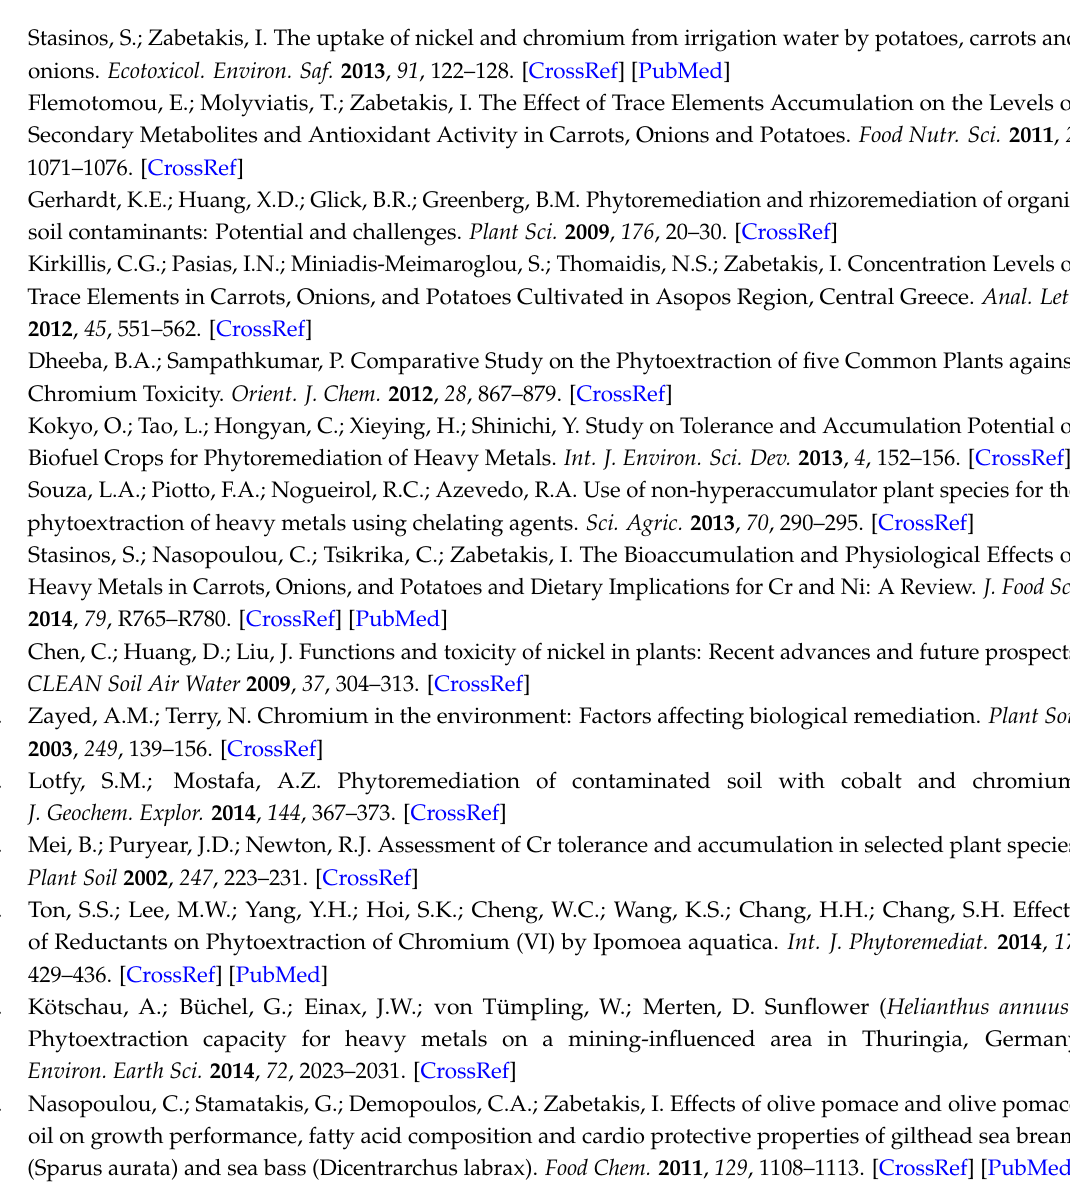
Figure S1: Levels of: (a) chromium and (b) nickel as determined by Atomic Absorption Spectroscopy (AAS) in roots, shoots, leaves, and blossoms in different irrigation lines. Table S1: Two by two comparisons of Cr and Ni between different concentrations in irrigation